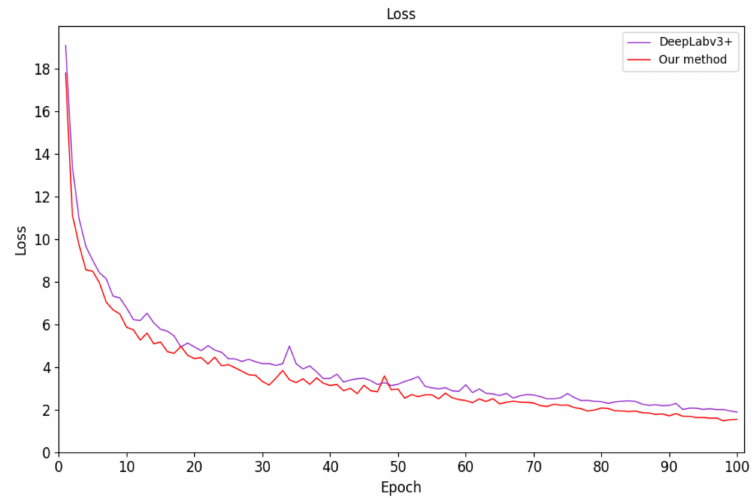
Figure 7. Network-model-training loss curve.